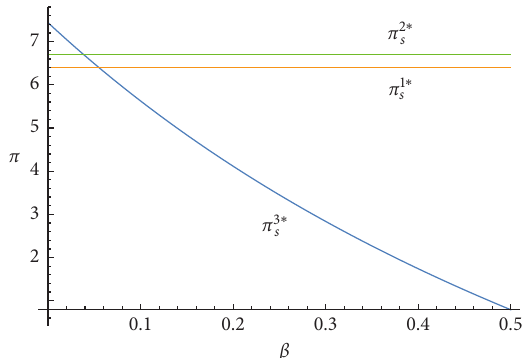
Figure 4: Effects of β on the maximum expected profit of the